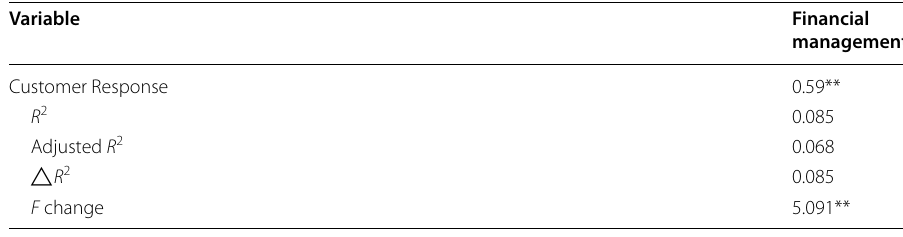
Level of significant: * p < 0.10, ** p < 0.05 Table 8 Multiple regressions: customer responses and operational management (Beta coefficient)